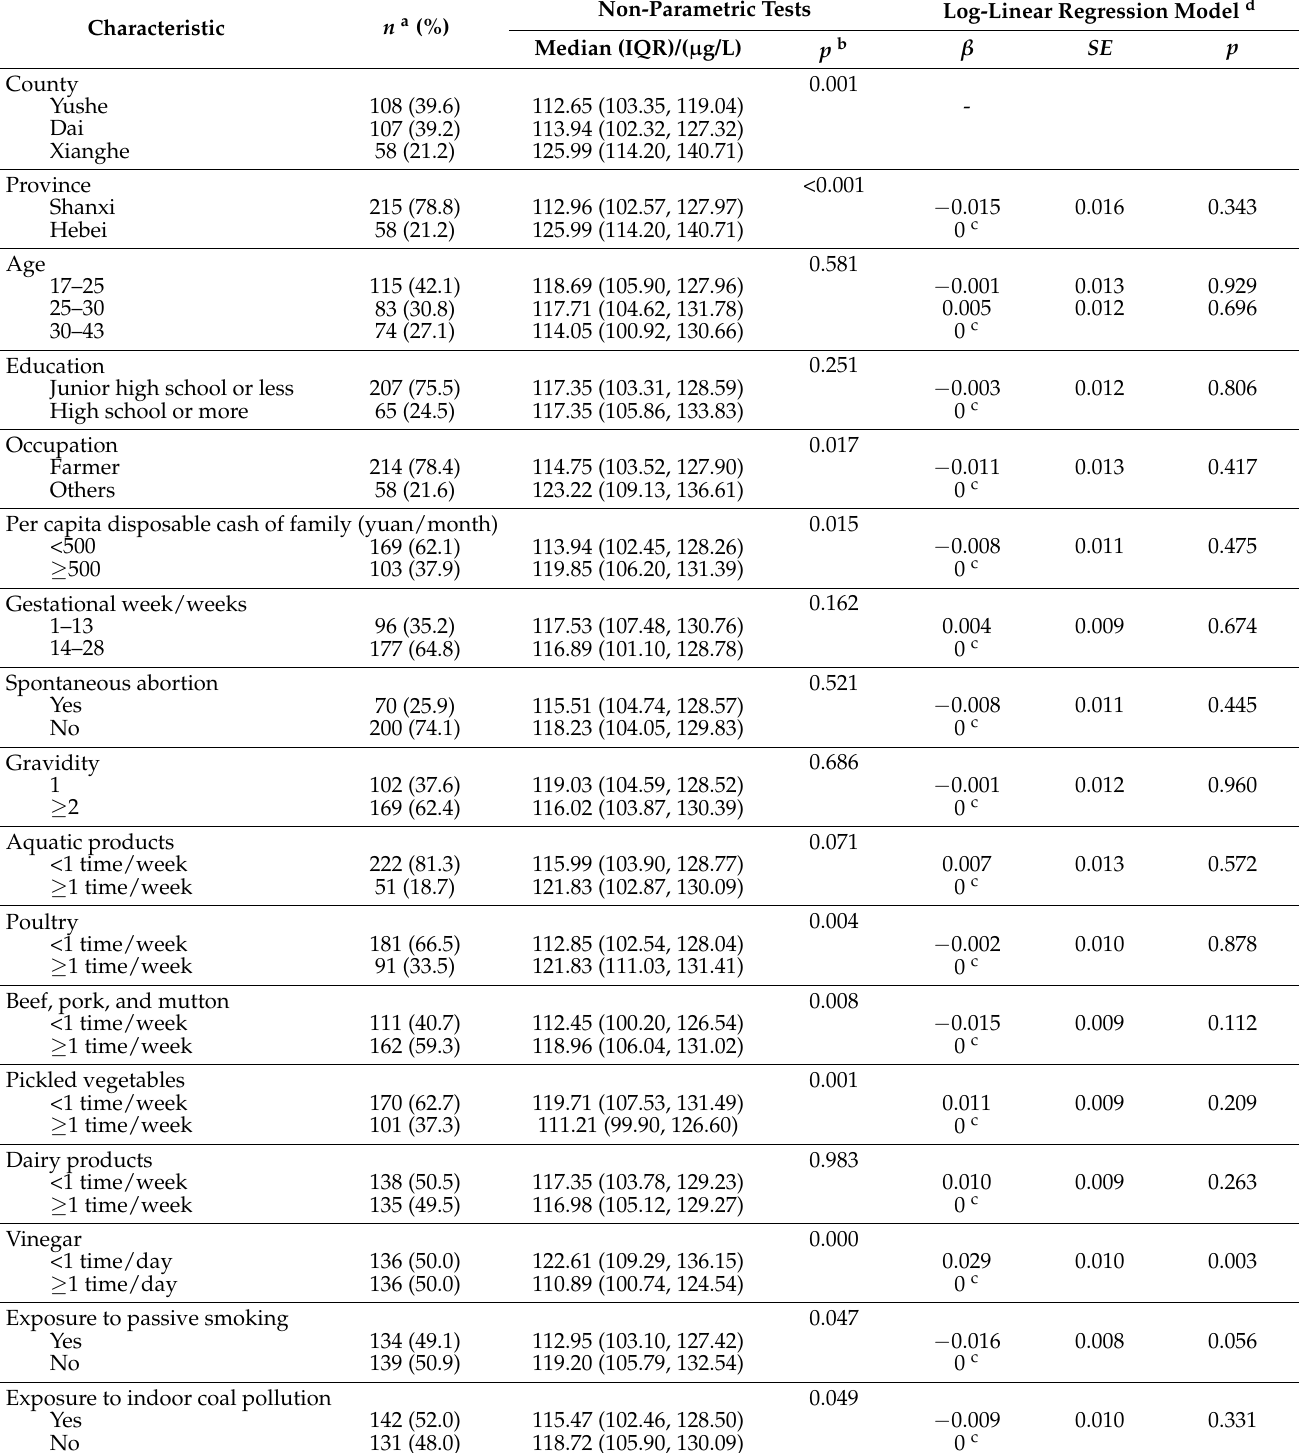
Table 2. Se concentrations in blood in pregnant women and associated